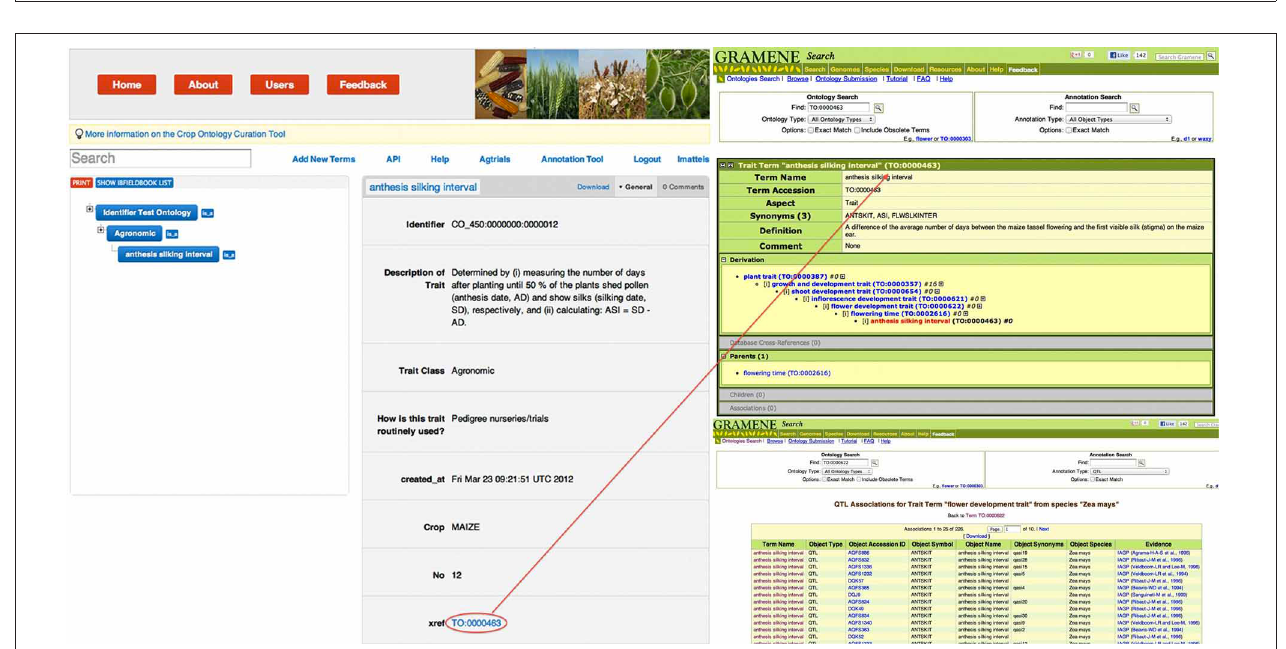
annotation(C)informationandimagesaboutthecorrespondingontological termaredisplayedbelowthetermselectedforannotation(e.g.,anthesis silkinginterval).Userscancheckandvalidateorrejecttheproposition.